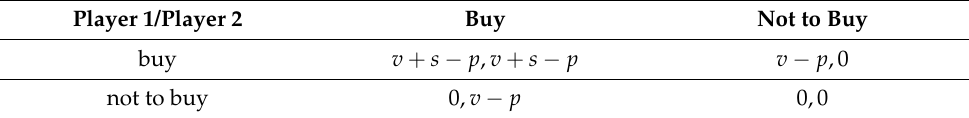
Table 3. Matrix of payoffs